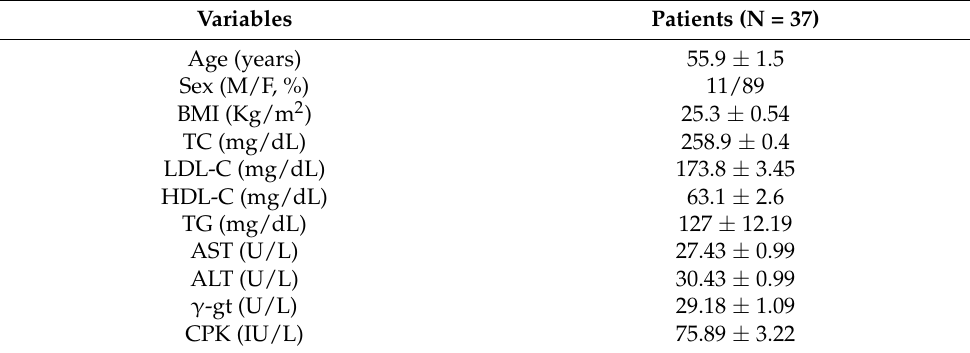
Table 2. Baseline characteristics and lipid profile of the study